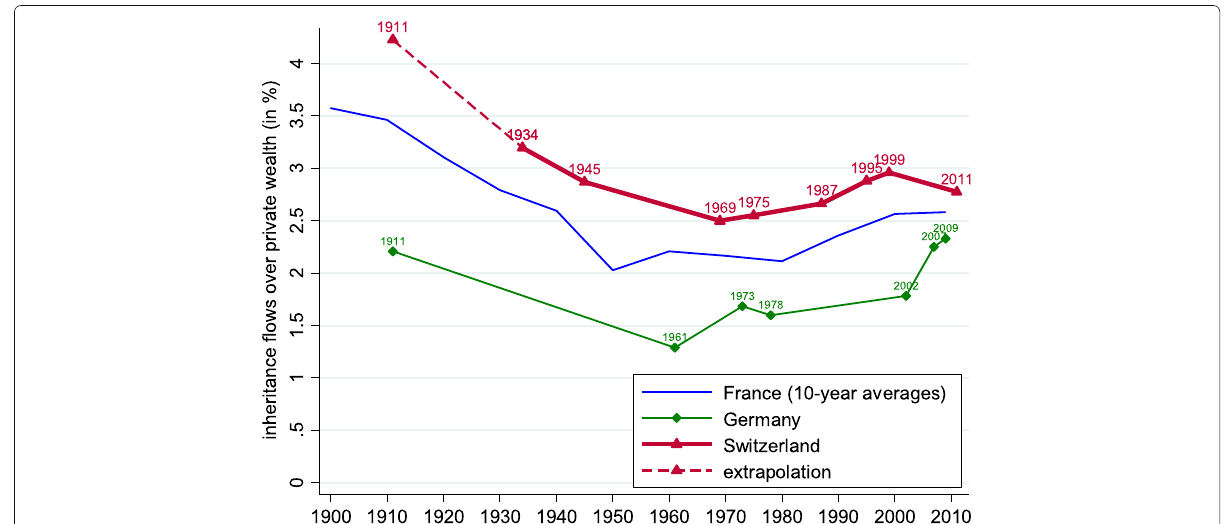
Fig. 3 Annual inheritance flow as a fraction of private wealth: Switzerland, France and Germany. Notes: Data for France from Piketty (2011). Data for Germany from Schinke (2012). See text for Swiss data sources, and Table 1 for data points